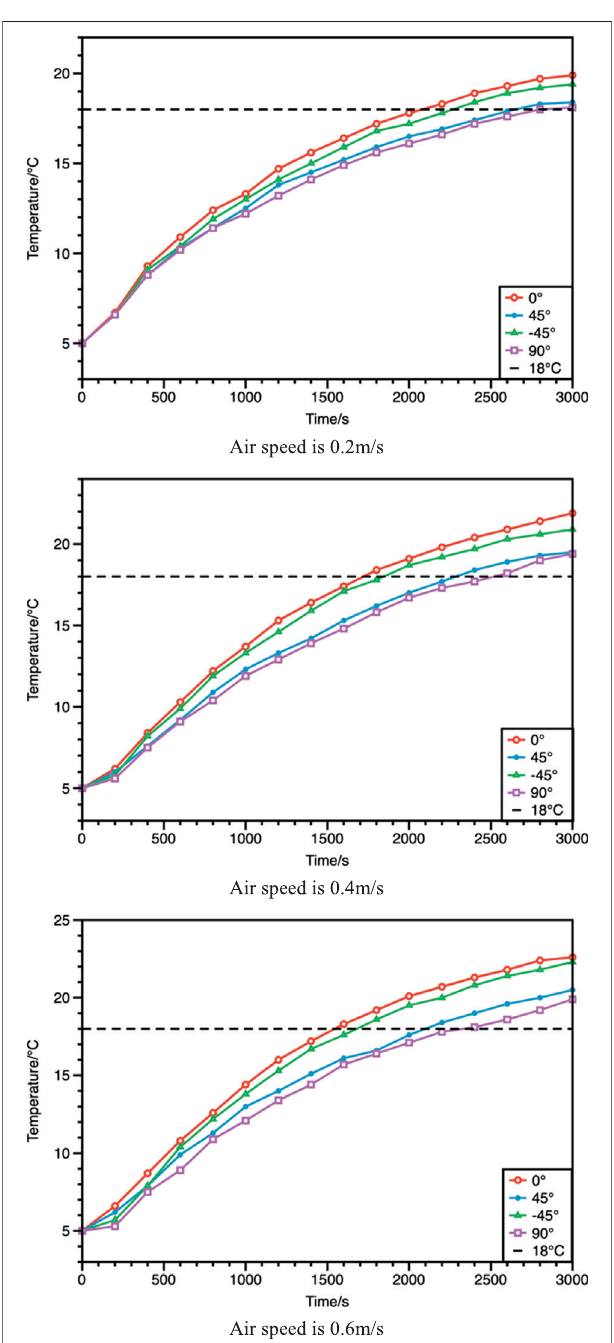
FIGURE 9 | Average temperature change curve at 1.1-m height plane.